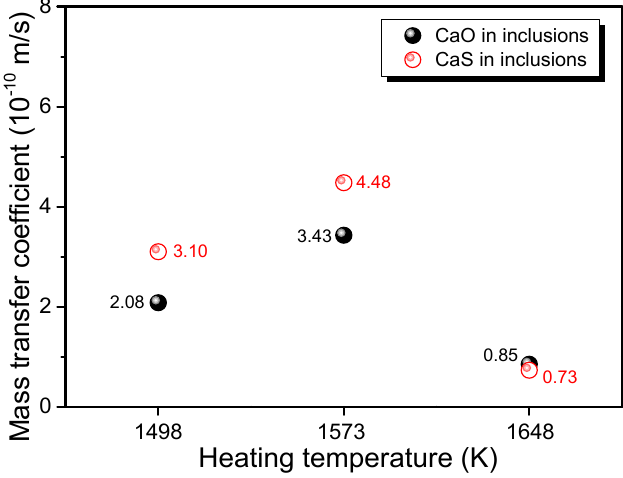
Figure 23. Effect of temperature on the mass transfer coefficient of inclusion components Figure 23. E ff ect of temperature on the mass transfer coe ffi cient of inclusion